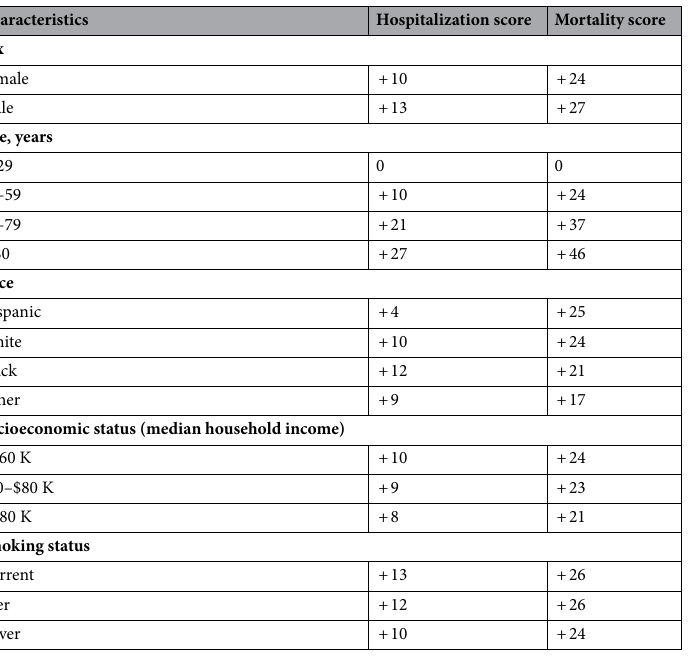
Table 3. SARS2 risk scores. The scores are defined for hospitalization within 30 days from COVID-19 diagnosis, and mortality within 74 days of the diagnosis. Score categorization: Hospitalization: Low risk: score < 39, Intermediate risk: 39 ≤ score < 44, High risk: score ≥ 44. Mortality among hospitalized patients: Low risk: score < 89, Intermediate risk: 89 ≤ score < 92, High risk: score ≥ 92. The prevalence of hospitalization within 30 days from COVID-19 diagnosis in the low, intermediate, and high risk groups were 2.75%, 8.47%, 22.85%, respectively. The incidence of mortality over approximately 3 months among hospitalized patients with COVID-19 diagnosis ranged from zero 0.92% in the low-risk group, to 4.44% in the intermediate- and 26% in the high-risk groups. According to the US Census 2018, the lower median income cutoff ($60 K) represents the lower 62% of the population, and the high-income cutoff ($80 K) represents the top 15% of the